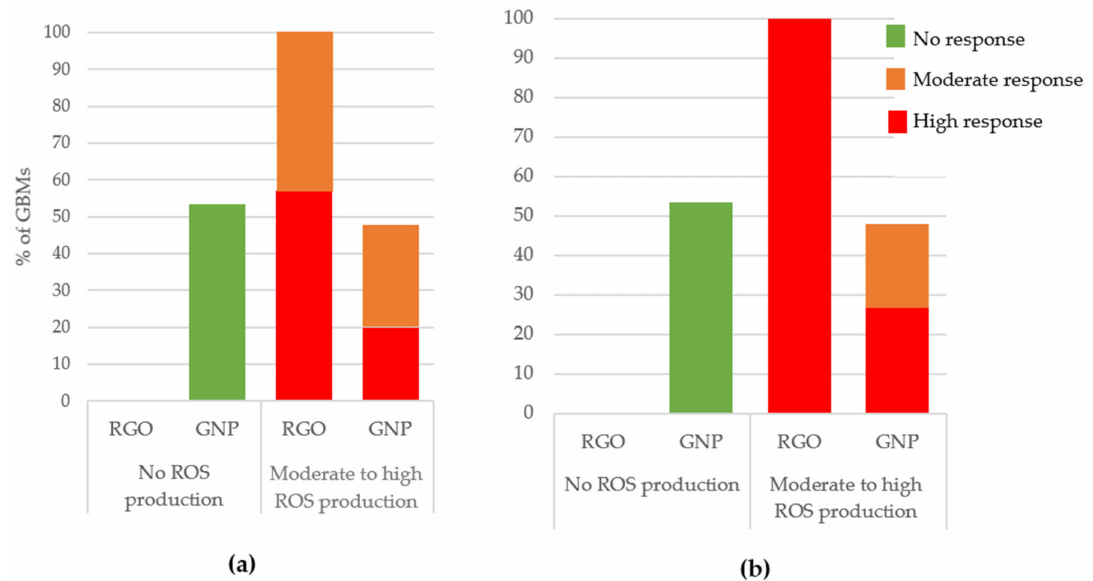
Figure 4. ROS production classification after 90 min ( a ) or 24 h ( b ) of exposure depending on GBM type. Three independent experiments were performed, each in duplicate, and the production of ROS was reported to that of control cells (incubated without nanoparticles), then we considered the distribution of GNP and RGO in the groups showing no, moderate, or high ROS